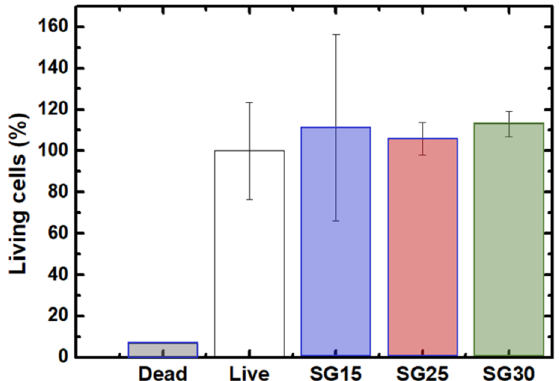
Figure 8. Quantitative data for live/dead assay after 1 week in culture.